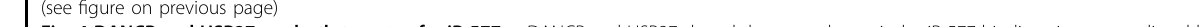
Fig. 4 DANCR and HSP27 are both targets of miR-577. a DANCR and HSP27 shared the same theoretical miR-577 binding sites, as predicted by targetscan and DIANA-LncBase. b miR-577 was expressed at a lower level in CRC tissues and cell lines than in non-CRC tissues and NCM460, as measured by qRT-PCR. U6 was used as the normalization control. ## P < 0.01 vs. the non-CRC group, ** P < 0.01 vs. the NCM 460 group. c miR-577 was up- and down-regulated by transfection of pre-miR-577 or anti-miR-577, as detected by qRT-PCR; &P > 0.05, *** P < 0.001 vs. control group. d HSP27 was negatively regulated by miR-577, as determined by qRT-PCR and western blotting; & P > 0.05, ** P < 0.01 vs. the control group (Nos. 1 – 5 represent the control group, pre-miR-577-NC group, pre-miR-577 group, anti-miR-577-NC group and anti-miR-577 group, respectively). e Diagram of the constructed HSP27 reporter plasmid containing the wild-type or mutant miR-577 binding site. f Co-transfection of pre-miR-577 and pmirGLO-HSP27- wt led to signi fi cant weakening of fl uorescence compared with the pre-miR-577 and pmirGLO-HSP27-mut co-transfection group, as determined by luciferase assays. & P > 0.05, ** P < 0.01 vs. the pre-miR-577-NC group. g Diagram of the constructed DANCR reporter plasmid containing wild-type or mutant miR-577 binding sites. h DANCR was also negatively regulated by miR-577, as determined by qRT-PCR; & P > 0.05, ** P < 0.01 vs. the control group. i , j Weakened fl uorescence was present in the pre-miR-577 and pmirGLO-HSP27-wt co-transfection groups, as determined by luciferase assays. & P > 0.05, ** P < 0.01 vs. the pre-miR-577-NC group. k , l The RIP assay was performed using input from the cell lysate, normal mouse IgG or anti-Ago2. Relative expression levels of DANCR and miR-577 were determined by qRT-PCR. ** P < 0.01 vs. the anti-normal IgG group. The data are shown as the means ± SD from three independent